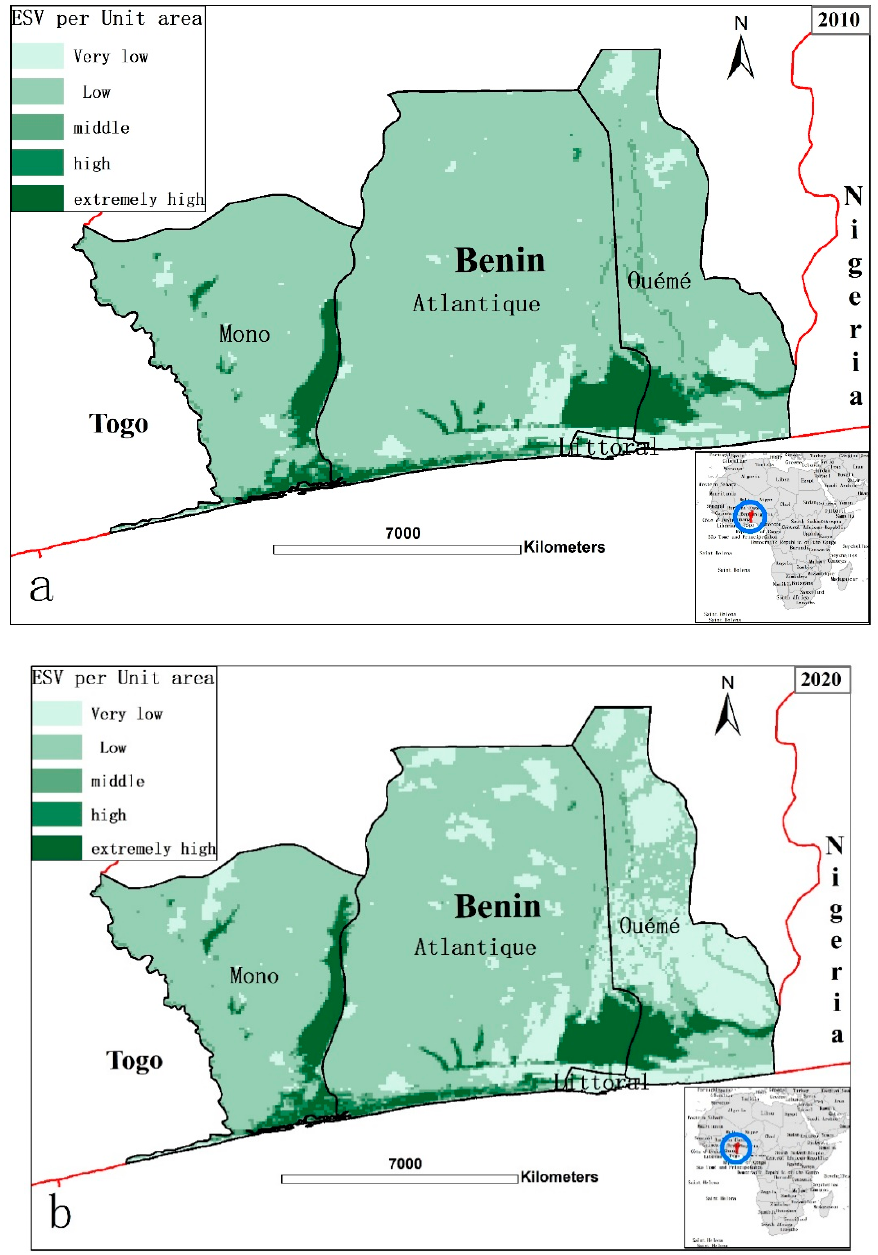
Figure 6. Spatial patterns of ESV in the tropical coastal area of Benin. ( a ) Spatial patterns in 2010, ( b ) Spatial patterns in 2020.